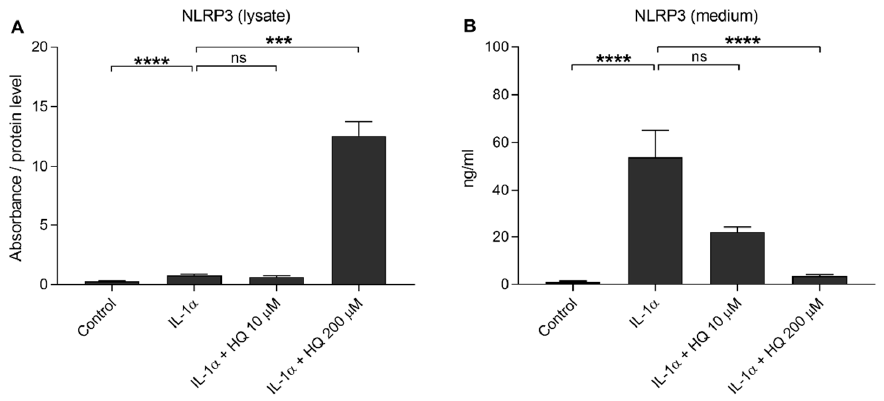
Figure 3. The effect of hydroquinone (HQ 10 μ M, 200 μ M; 18 h) on the levels of NLRP3 in cell lysate ( A ) and medium ( B ) samples in IL-1 α -primed ARPE-19 cell cultures. Results ( A ) were normalized to the total protein level. Absorbance values in ( A ) were 0.263–0.507 in the control, 0.548–1.516 in the IL-1 α , 0.416–0.862 in the IL-1 α + HQ 10 μ M, and 4.492–9.375 in the IL-1 α + HQ 200 μ M group. NLRP3 concentrations in medium samples ( B ) were 0.590–2.054 ng/mL in the control, 11.81–161.453 ng/mL in the IL-1 α , 10.345–28.244 ng/mL in the IL-1 α + HQ 10 μ M, and 1.268–6.303 ng/mL in the IL-1 α +